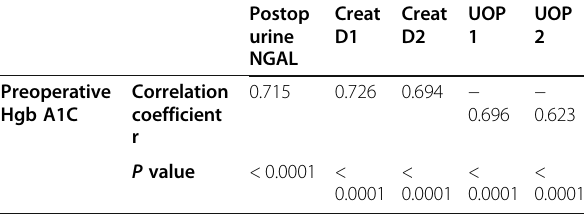
Table 7 Correlation table between preoperative Hgb A1c and AKI